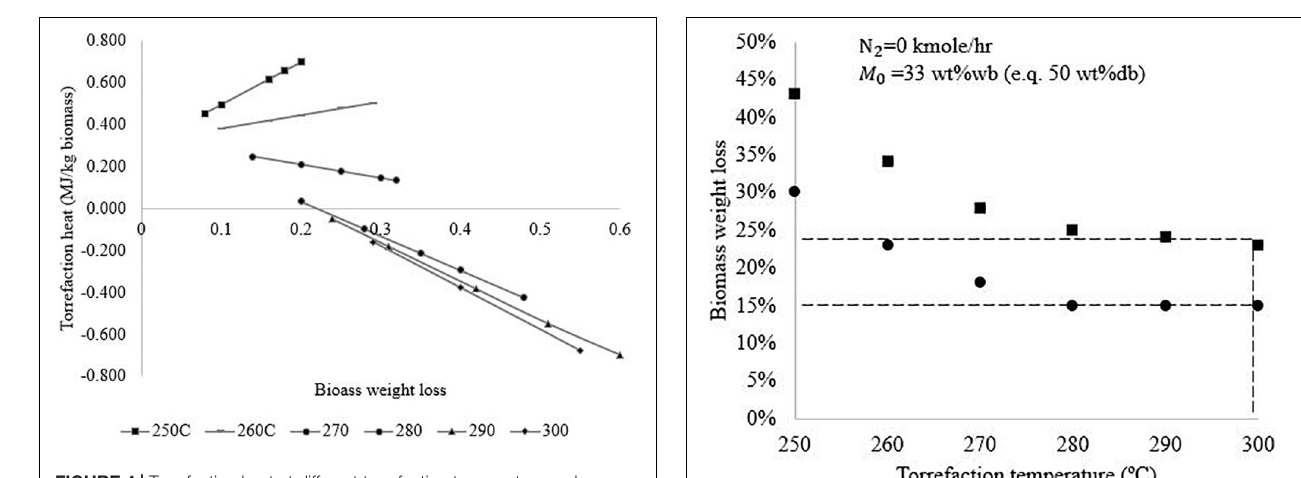
FIGURE 4 | Torrefaction heat at different torrefaction temperature and biomass weight loss.